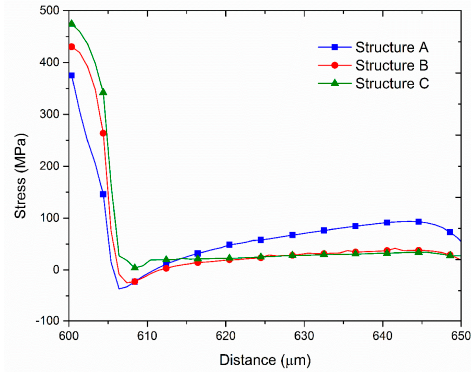
Figure 11. Simulated stress distributions in the BLC areas.